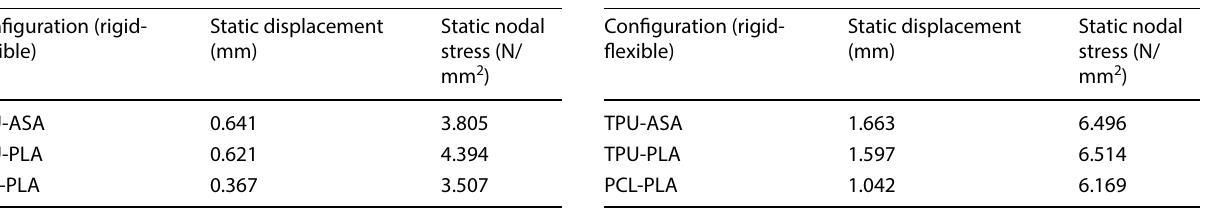
Table 2 Power grasp (first configuration) Table 3 Payload (second